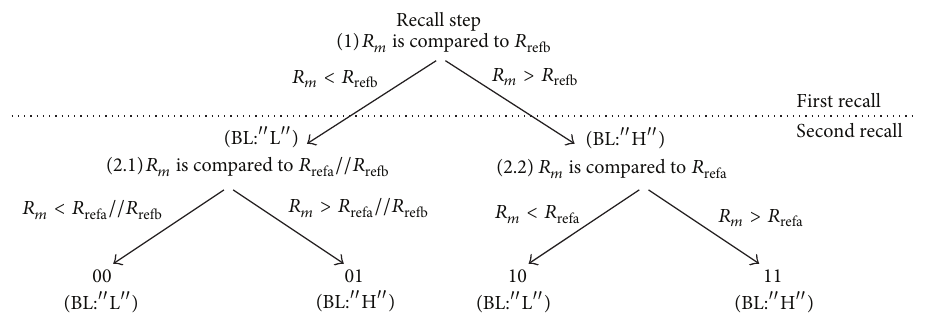
Figure 6: Recall step for MNV-SRAM.